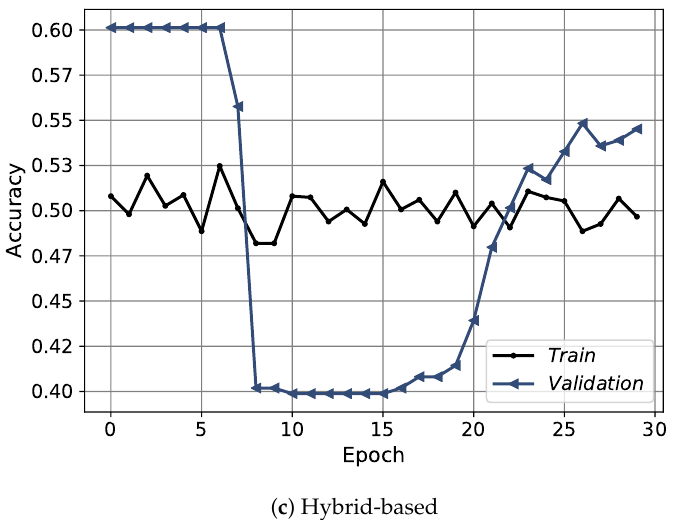
Figure 12. The convergence curves in terms of the accuracy of the best models for the three approaches using the spectral features only, the transcript features only, and the hybrid of both.